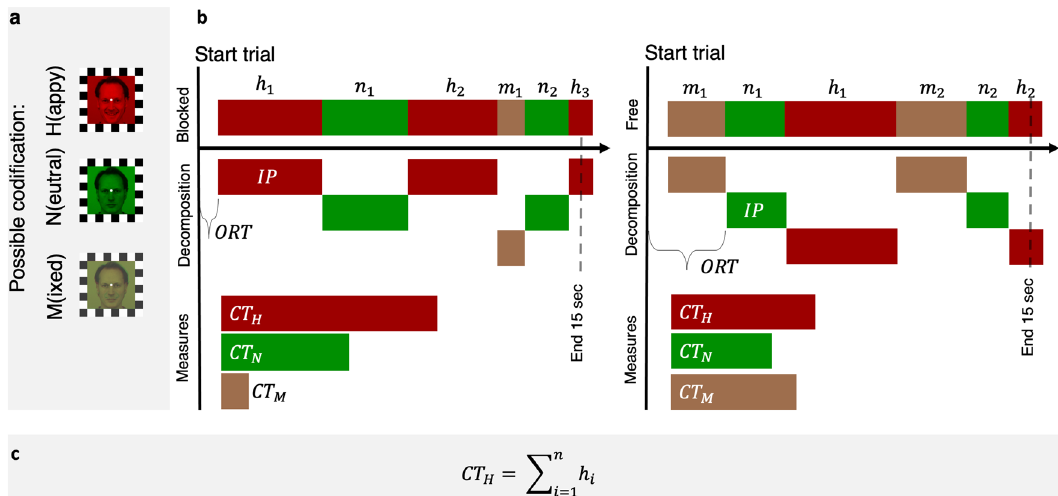
Figure 1. Rivalry during trials and BR measures. ( a ) Possible coding of the rival stimuli. Original pictures (AM10NES AM10HAS) of facial expressions have been selected from the Karolinska Directed Emotional Faces set (KDEF; https:// www. kdef. se/) and modified using GIMP (version 2.8.10, https:// www. gimp. org). ( b ) An example of a subject rivalry trials and coded percepts (e.g., h1: first happy face coded in a trial, n1: first neutral face coded in a trial, m1: first mixed percept coded in a trial…). The three behavioral measures that we extract from this time course are (1) initial percept (IP) (either Happy, Neutral), (2) onset resolution time (ORT in [s]), and (3) cumulative time (CT for percept in [s]), formula in ( c